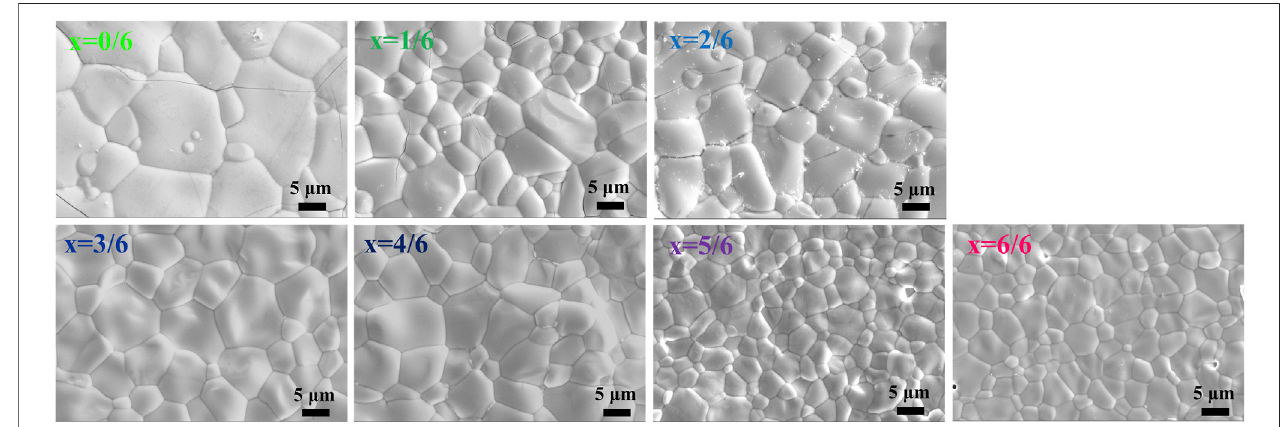
FIGURE 2 | Surface microstructure of (La 1-x Ho x ) 3 NbO 7 ( x (cid:2) 0/6, 1/6, 2/6, 3/6, 4/6, 5/6, and 6/6) ceramics.